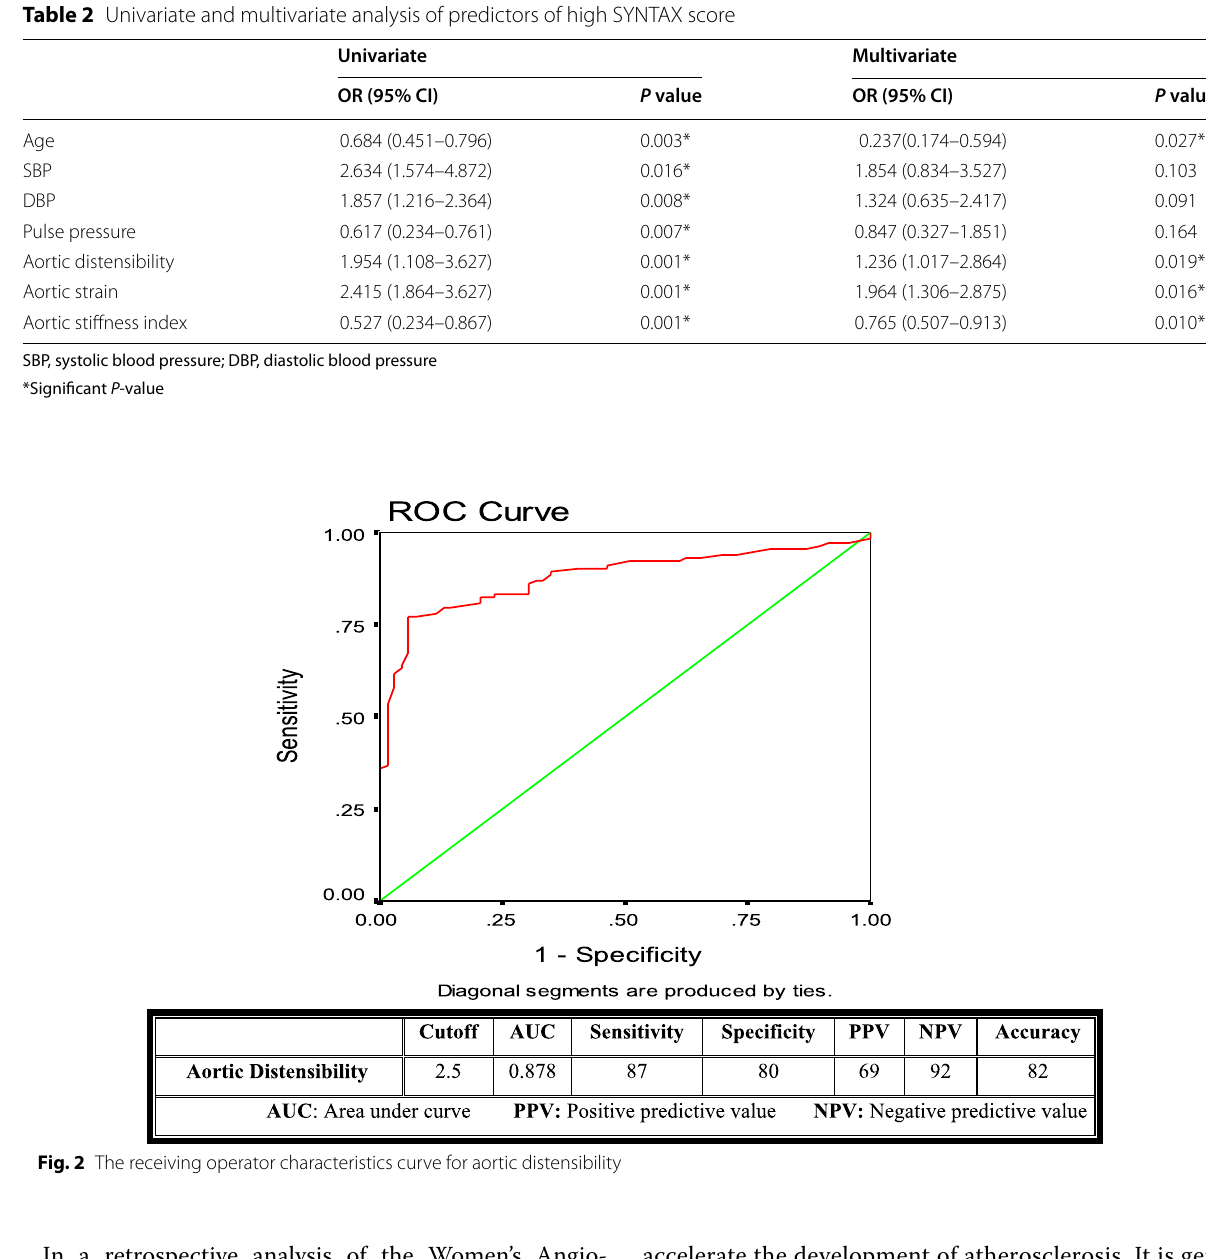
Table 2 Univariate and multivariate analysis of predictors of high SYNTAX score